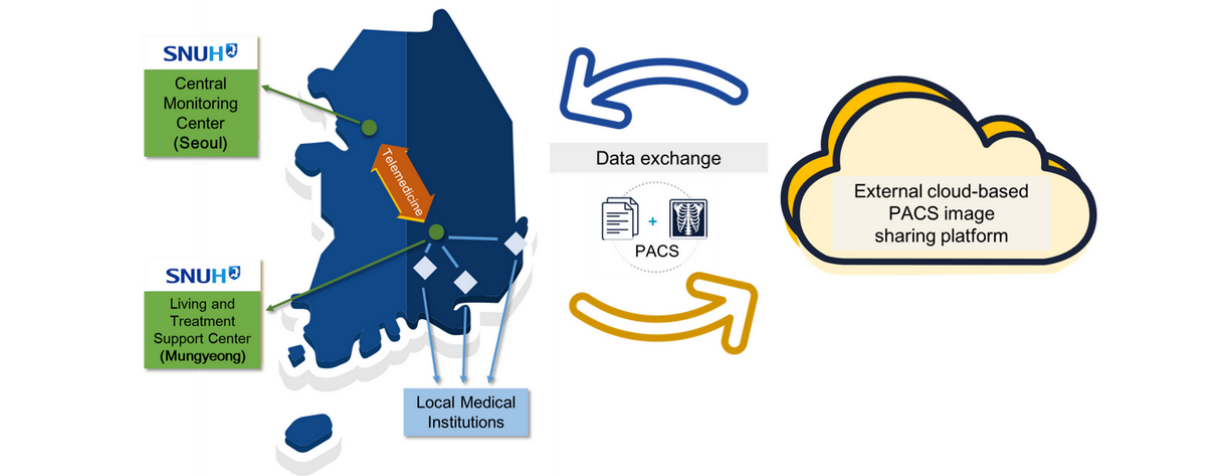
Figure 4. The cloud-based medical image sharing platform. PACS: picture archiving and communication system. SNUH: Seoul National University